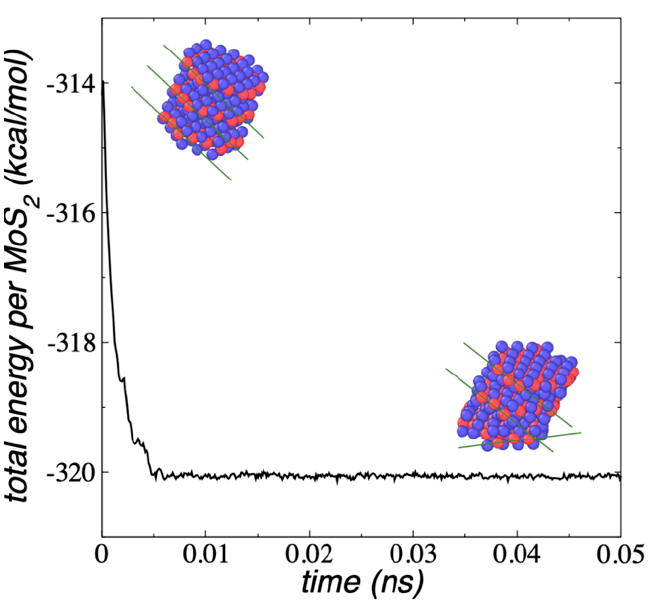
Figure 8. E #MoS2 of 3L Mo 27 S 54 flake as a function of simulation time, under vacuum and NVT conditions at 298.15 K. The inset snapshots correspond to the initial (3R, same orientation in all layers, top) and equilibrated (1-1L with shifted orientation of 60°, bottom) conformations of the flakes. Blue and red spheres represent Mo and S atoms, respectively .